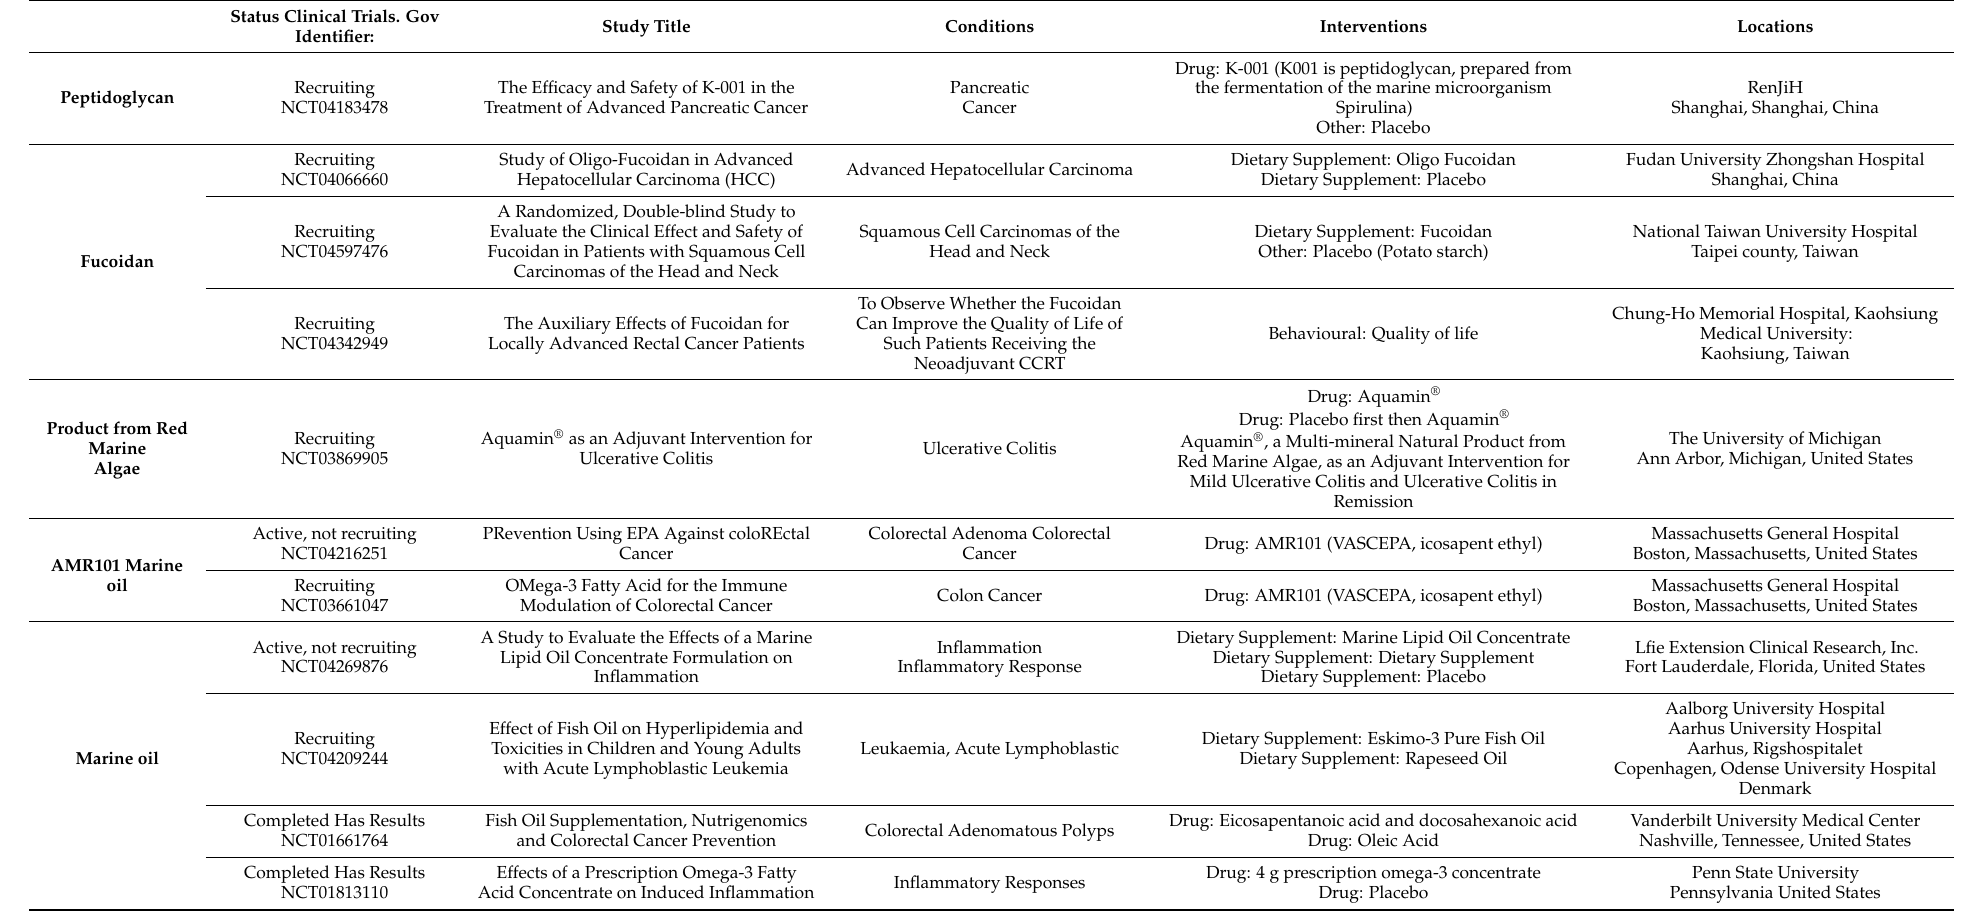
Table 3. Summary of relevant clinical trials employing the marine compounds endowed with anti-cancer activity (treatment and/or chemoprevention). Status Clinical Trials. Gov